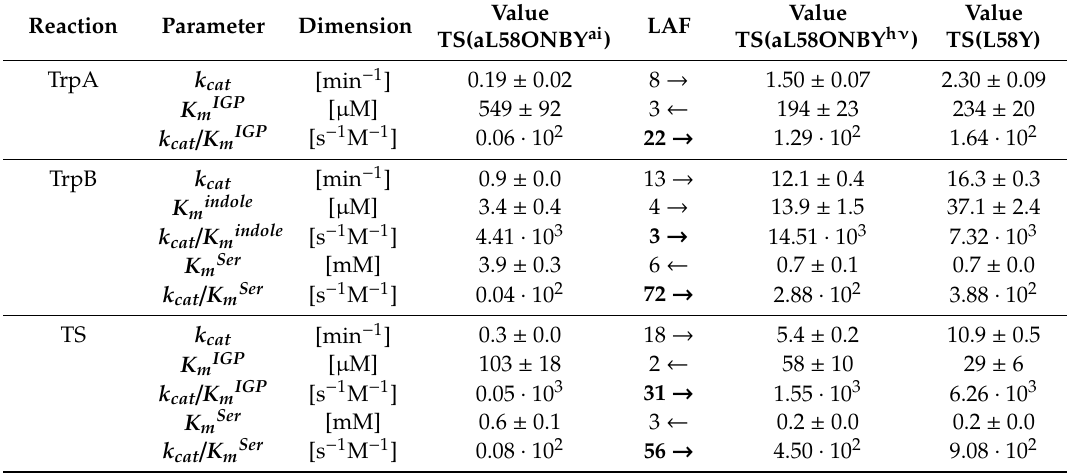
Table 2. Steady-state kinetics of TS(aL58ONBY) in its “as isolated” state (ai) and after irradiation (h ν ), and TS(aL58Y) for the TrpA and TrpB partial reactions, and the overall TS reaction. Reaction Parameter